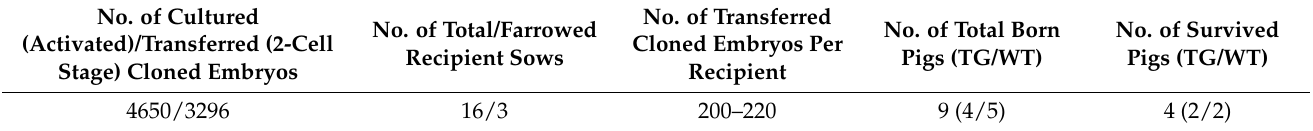
Table 1. Summary for production of F 0 generation hNGF-TG